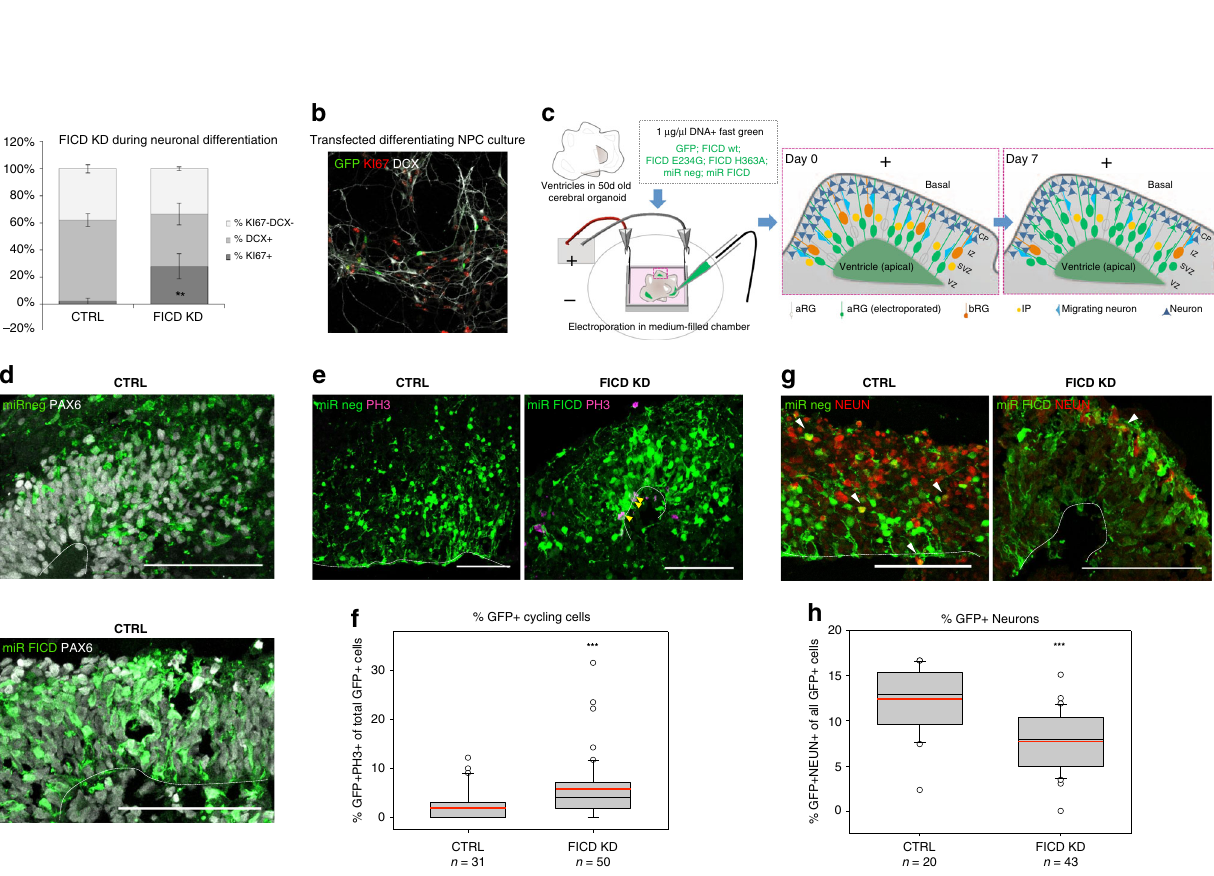
Fig. 6 Downregulation of FICD levels keeps differentiating neurons in a cycling state. a Quanti fi cation of IHC staining for the proliferation marker KI67 + and the early neuronal marker doublecortin (DCX) showed that FICD KD leads to a signi fi cant increase in KI67 + compared to control, while the number of generated neurons tends to be decreased (analysis of 3 coverslips/condition with at least 20 transfected cells each; two-tailed Student ’ s t-test: KI67 + : * P < 0.05; DCX + : P = 0.068 ). b Example image of transfected and IHC stained culture with transfected cells (GFP + ) in green, proliferating cells (KI67 + ) in red and differentiating neurons (DCX + ) in white. c Scheme showing the electroporation of DNA into ventricle-like structures of cerebral organoids (COs) and the organisation of different cell types within the germinal zone. DNA (constructs are listed; supplemented with fast green for visualisation) is injected into the lumen and taken up by aRG via their apical processes. The transfected construct can be found in IPs and neurons upon differentiation of transfected aRG (green, 7 days post electroporation (dpe)) (VZ = ventricular zone, SVZ = subventricular zone, IZ = intermediate zone, CP = cortical plate; aRG = apical radial glia, bRG = basal radial glia, IP = intermediate progenitor). d Upon acute miRNA-mediated KD of FICD in ventricles of COs (50d + 7), most GFP + cells (green) have aRG identity (PAX6 + , white). e , f FICD KD leads to an increased number of cycling progenitors ( e IHC staining for PH3 + cells in M-Phase. GFP + PH3 + cells marked by yellow arrowheads; f Quanti fi cation of GFP + PH3 + progenitor cells 7 dpe). g , h aRG transfected with FICD- targeting miRNAs differentiate less to neurons ( g , IHC staining for neuronal nuclei marker NEUN, red; GFP-positive neurons shown by white arrowheads; h , Quanti fi cation of GFP + neurons 7 dpe shows signi fi cant decrease upon FICD knockdown). d, e, g 50 + 7d old organoids; electroporated cells and their progeny shown in green; Scalebar = 50 µ m, dotted line = apical surface. f, h 1 n = 1 electroporated germinal zone; box plot: mean (red line), median (black line), box represents 25th and 75th percentiles, whiskers extend to 10th and 90th percentiles, all outliers are shown; Signi fi cance was tested using Kruskal- Wallis One-way ANOVA on Ranks and Dunn ’ s Pairwise Multiple Comparison (*** P <